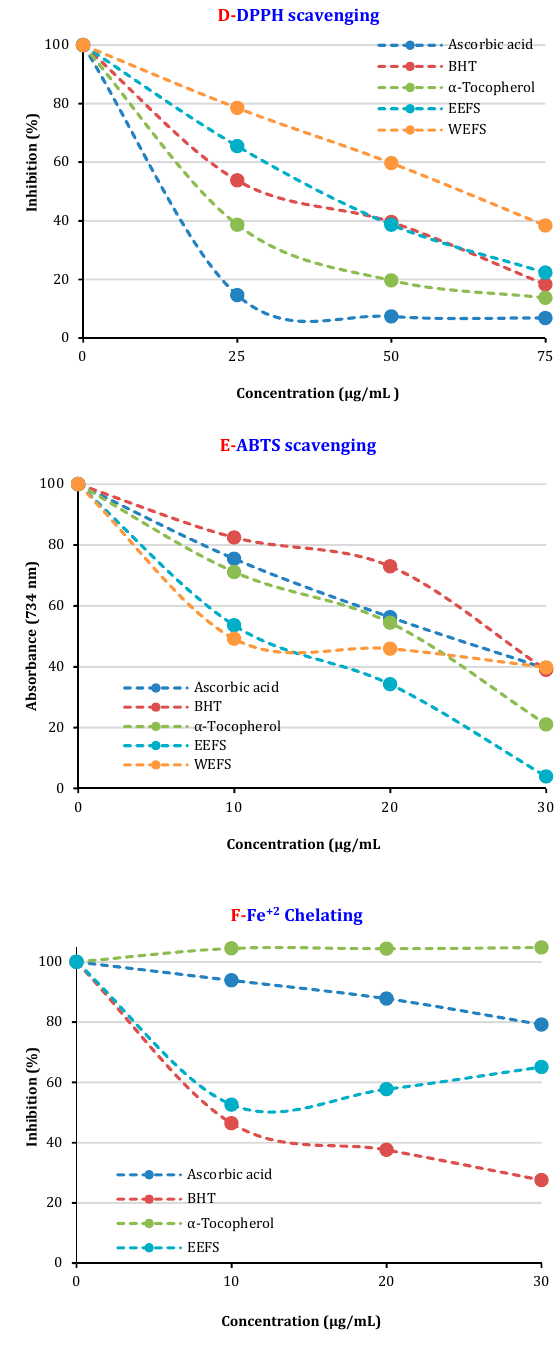
Figure 1. Fe 3+ reducing ( A ), Cu 2+ reducing ( B ), and Fe 3+ -TPTZ reducing ( C ); ABTS ( E ) and DPPH scavenging ( D ); and Fe 2+ chelating ( F ) activities of EEFS and WEFS ((EEFS: evaporated ethanolic extract of aerial parts kınkor ( Ferulago stellata ); WEFS: lyophilized water extract of aerial parts of kınkor ( Ferulago stellata ) TPTZ: 2,4,6-tris(2-pyridyl)-s-triazine; DPPH: 1,1-diphenyl-2-picrylhydrazyl; ABTS: 2,2 ′ -azino-bis(3-ethylbenzothiazoline-6-sulfonic acid)).